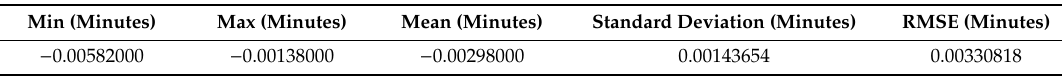
Table 14. Statistical values of the residuals for the North coordinates resulting from datum transformation UTM/ED50 to UTM/WGS84 based on automatic QGIS application. Table 15. Statistical values of the residuals for the longitude coordinates that result from datum transformation OSPM / ED50 to OSPM / WGS84 based on an automatic QGIS application.